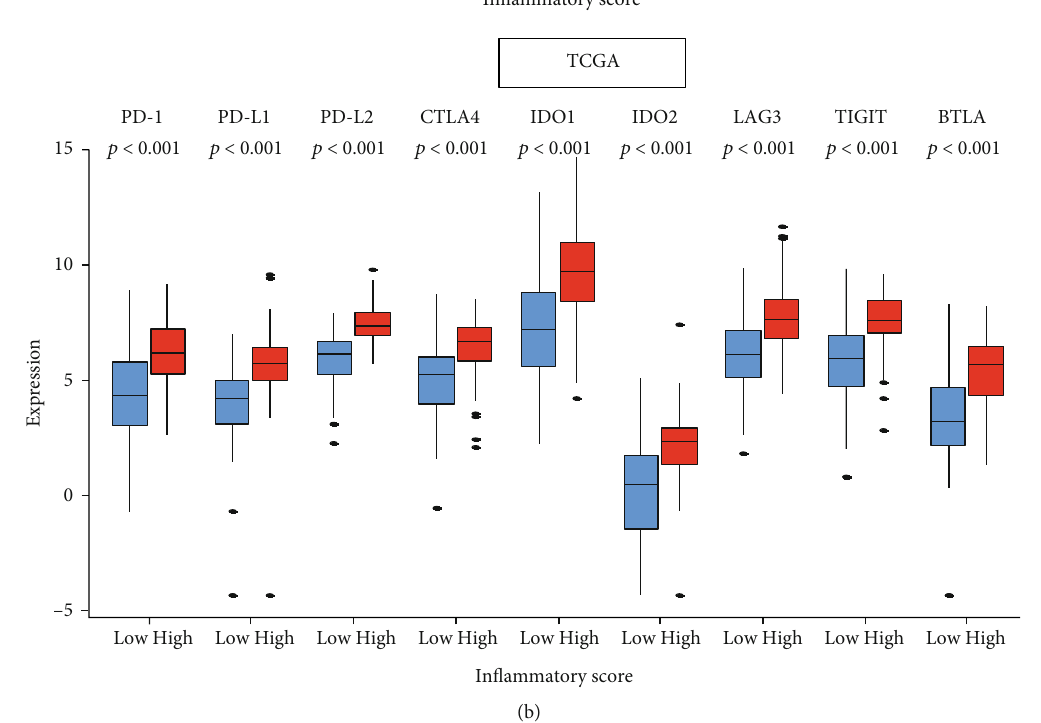
Figure 5: Relationships between the in fl ammatory score and neoadjuvant chemotherapy or expression of immune checkpoint molecules. (a) Percentage of achievement of pathological complete response (pCR) between low (blue bar) and high (red bar) in fl ammatory score in whole, TNBC and ER+/HER2- in the GSE25066 ( n = 467 ) and GSE20194 ( n = 248 ) breast cancer cohorts that underwent neoadjuvant chemotherapy. The number of patients who achieved pCR is shown below the plots. Fisher ’ s exact test is used to compare pCR rates between two groups. (b) Comparison of low (blue) and high (red) in fl ammatory score groups in gene expression of immune checkpoint molecules (log transcripts per million) in METABRIC and TCGA cohorts. In fl ammatory score in each cohort was divided into low and 2 high groups by the median values. Tukey-type boxplots show median and interquartile level values, and the ANOVA test is used to calculate p values. BTLA : B- and T-lymphocyte attenuator; CTLA4 : cytotoxic T-lymphocyte-associated protein 4; IDO1/2 : indoleamine dioxygenase 1/2; LAG3 : lymphocyte activation gene 3; PD-1 : programmed death-1; PD-L1 : programmed death ligand 1; TIGIT : tyrosine- based inhibitory motif